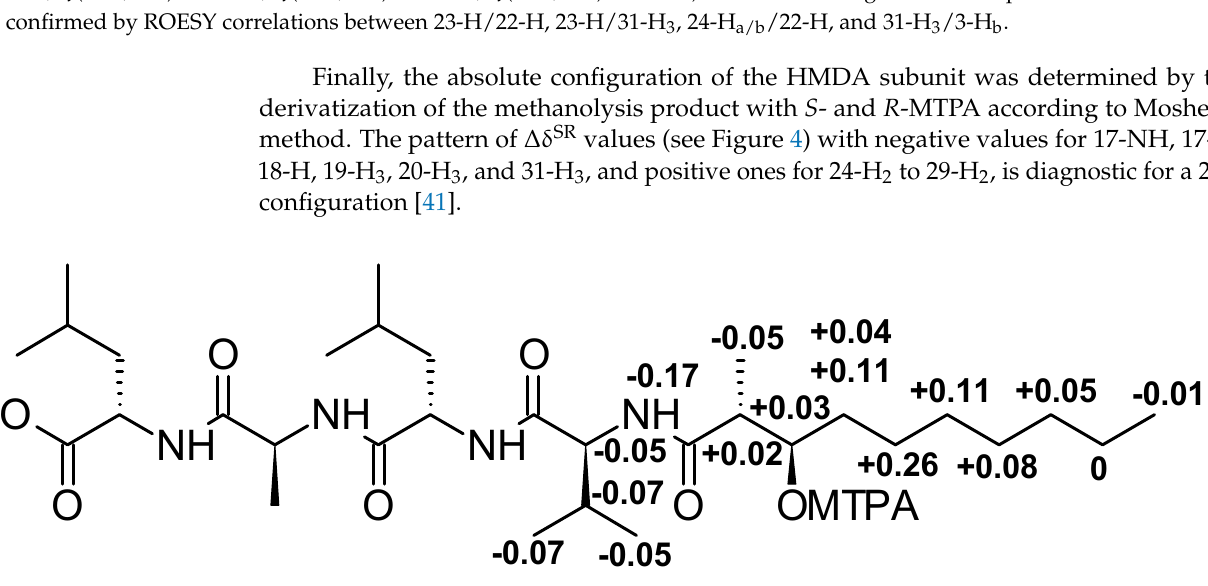
Figure 4. ∆ δ SR vvalues in ppm for the C-23-MTPA esters of 2 in pyridin-d 5 Figure 4. Δδ SR vvalues in ppm for the C-23-MTPA esters of 2 in pyridin-d 5 . Compounds 1 and 2 were not active against the microorganisms tested in the serial dilution assay. Compound 3 showed weak activity against B. subtilis and Mu. hiemalis (Table 3). Table 3. Minimum inhibitory concentration (MIC, µg/mL) of 1–3 against bacterial and fungal test organisms. Test Organism